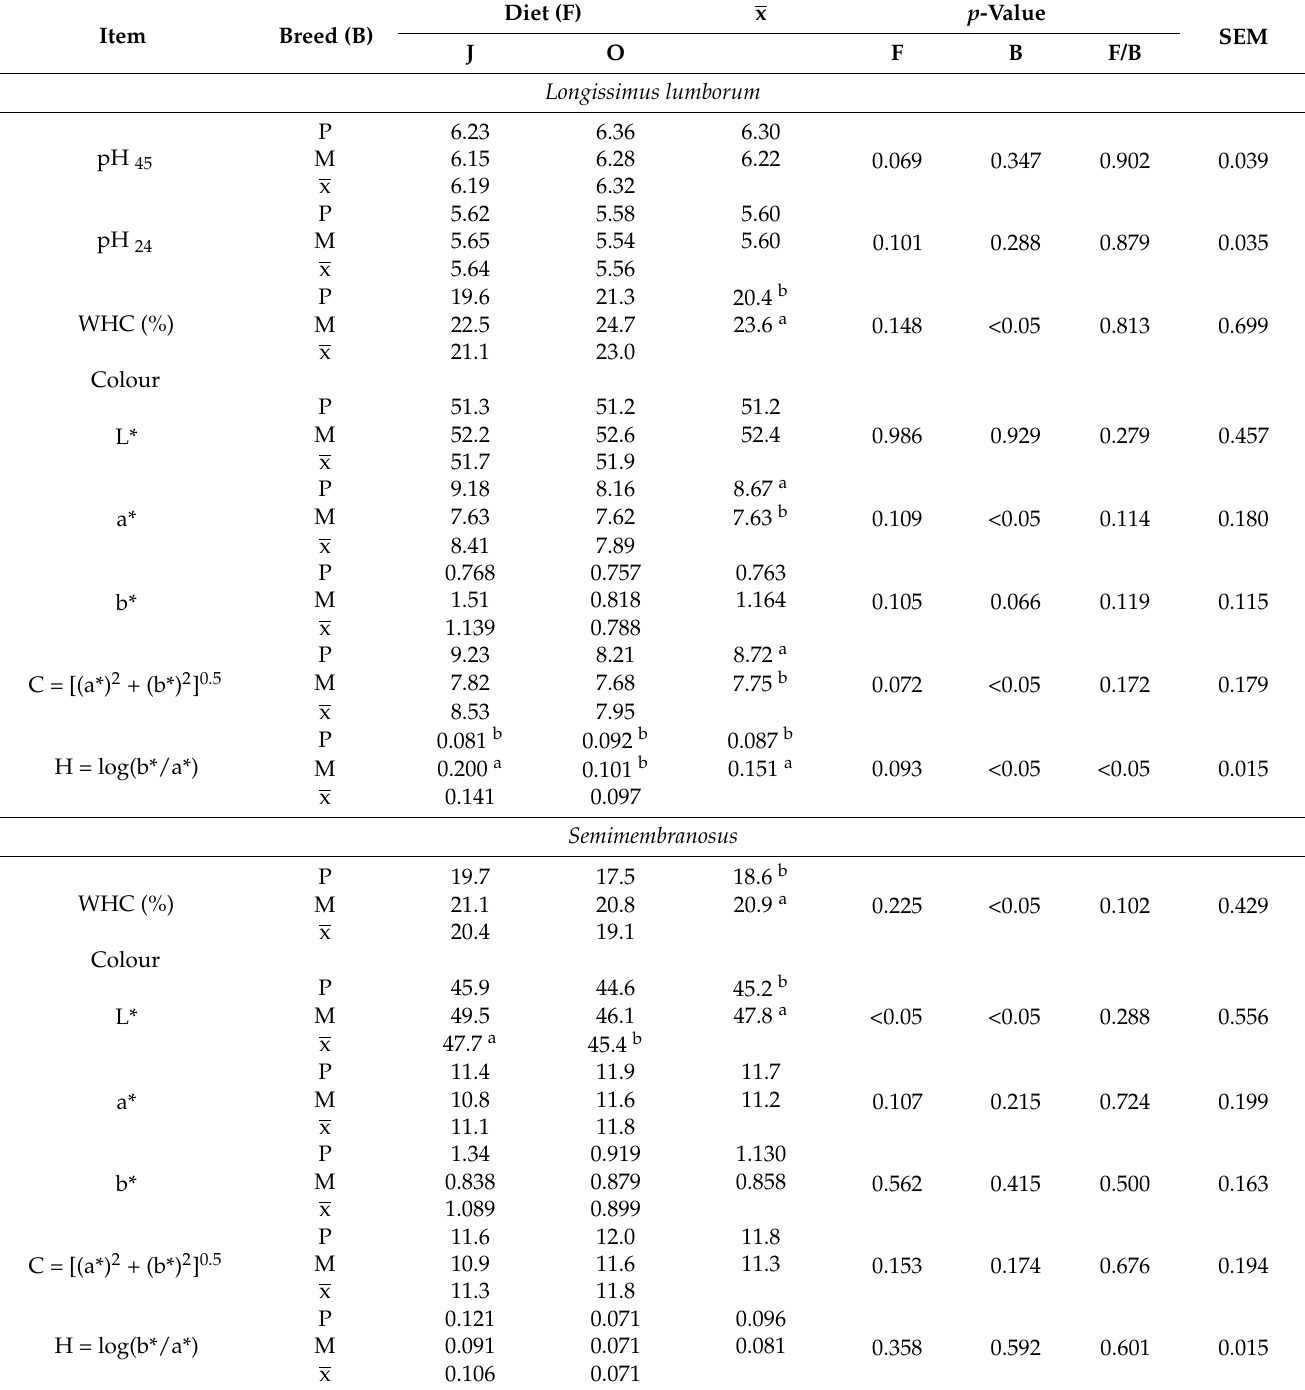
Table 5. Physical properties of